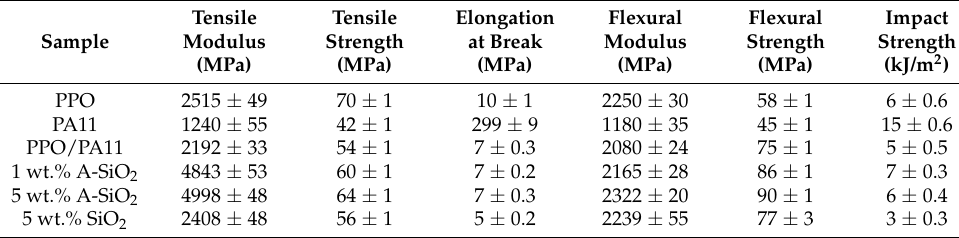
Table 4. Mechanical properties of PPO, PA11, and PPO/PA11/silica